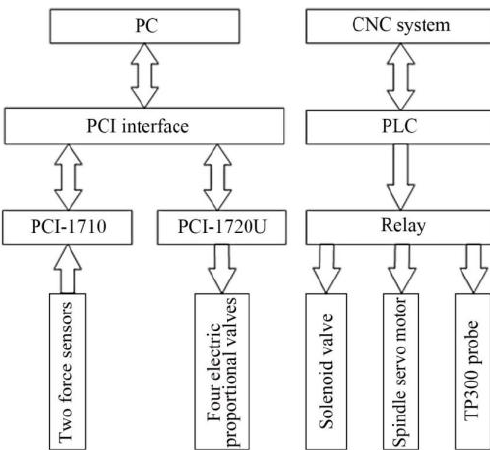
Figure 8. Control principle of the adaptive belt tool system.